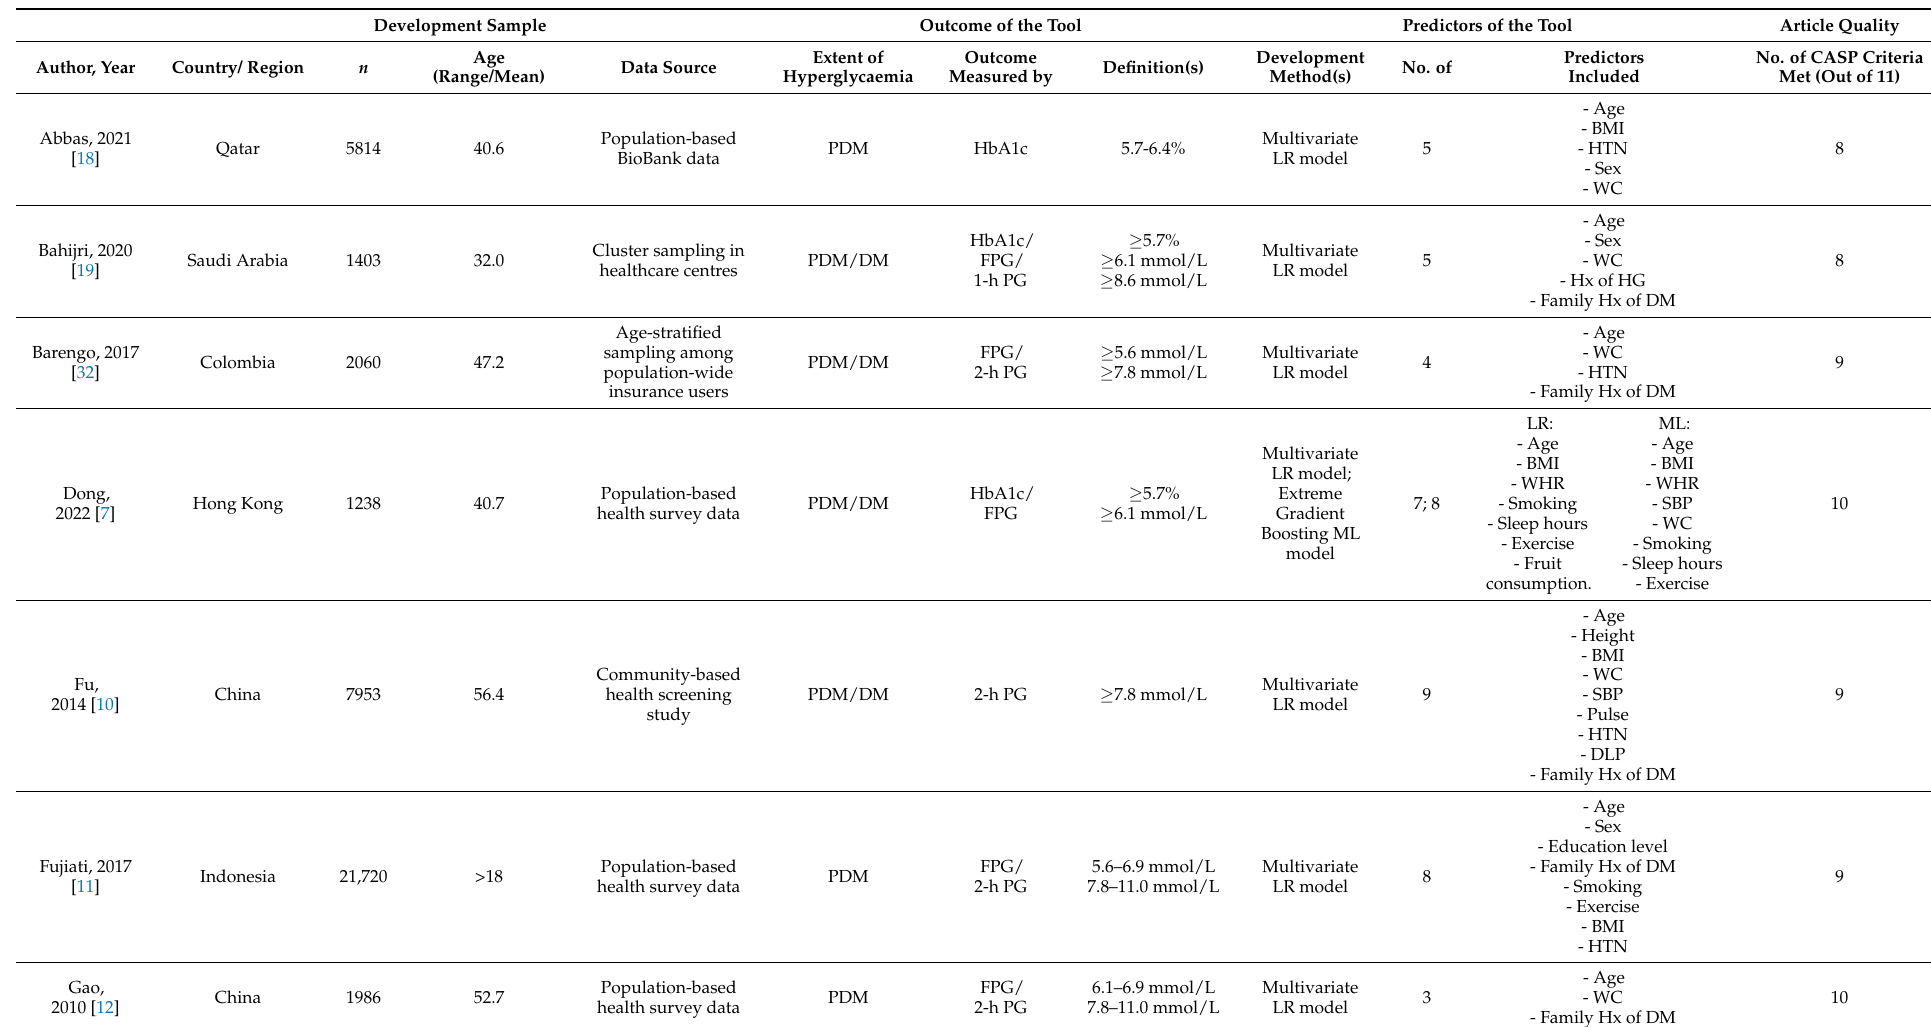
Table 1. Summary of study subject characteristics and prediction tools of the included studies ( n =